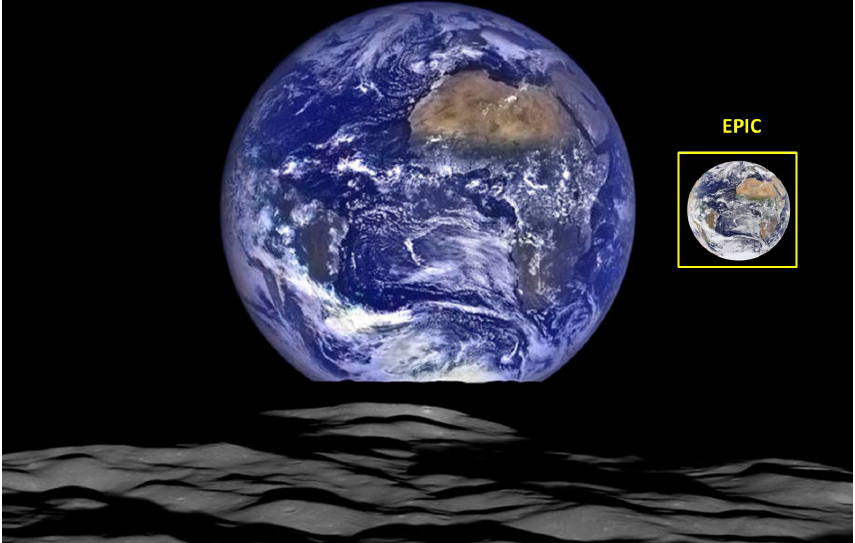
Figure 2. A unique view of Earth from the LRO’s vantage point in orbit around the Moon (12 October 2015). LRO was about 134km above the Moon’s far-side crater Compton (55 ◦ N, 104 ◦ E). The photograph is a combination of images in seven color bands from a wide-angle camera (WAC) and black and white images from two narrow-angle linear push-broom cameras (NACs) with a linear (one-dimensional) array of 5064 elements. Each NAC camera has a field of view of 2.86 ◦ . Image credit: NASA, GSFC, Arizona State University (https: //www.nasa.gov/image-feature/goddard/lro-earthrise-2015, last access: 18 March 2023). LRO data (Burns et al., 2012; Keller et al., 2016) can be of great help in planning Earth observations from the lunar surface. Insert shows an image of the same part of the Earth taken by DSCOVR-EPIC on the same day (12 October 2015) as it would be seen from the Lagrange